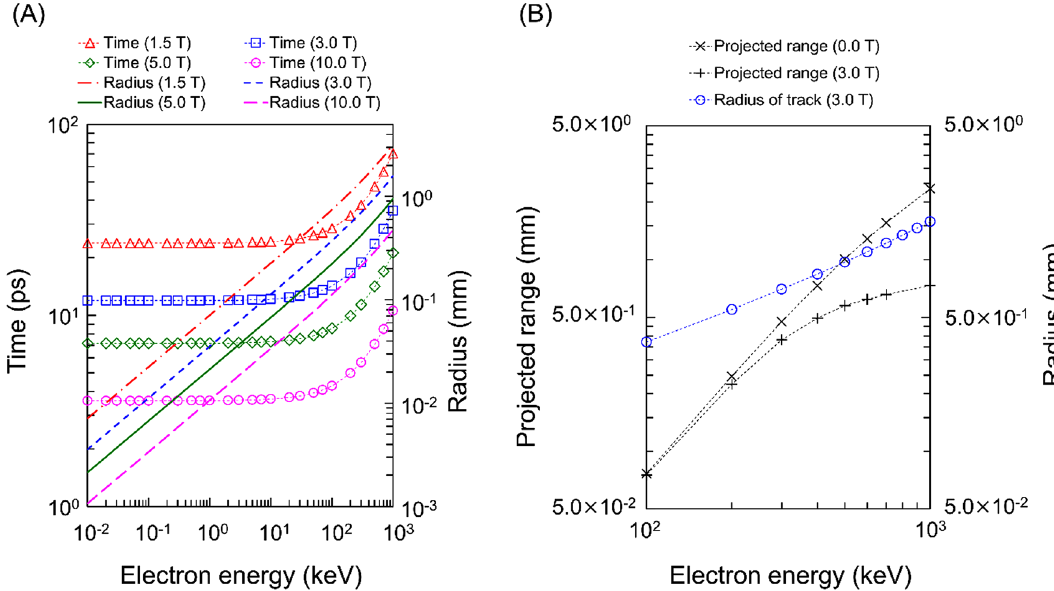
Figure 3. Gyration time and radius of electron tracks in vacuum in magnetic fields. ( A ) is the gyration time and the radius of monoenergetic electrons in vacuum as a function of incident electron energy. ( B ) is the gyration radius in vacuum and the projected range in liquid water for electrons with energy from 10 2 to 10 3 keV. In Fig. 3A, the monoenergetic electrons were simulated in various SMF strength ( B = 0.0–10.0 T). In Fig. 3B, the radius in vacuum with magnetic fields (blue circle) was compared to the range in liquid water without magnetic fields (cross symbols) and that in B = 3.0 T (plus symbols). The results show that the range for electrons below a few hundreds of keV is sufficiently smaller than the gyration radius in vacuum, suggesting the impact of Lorentz force is not